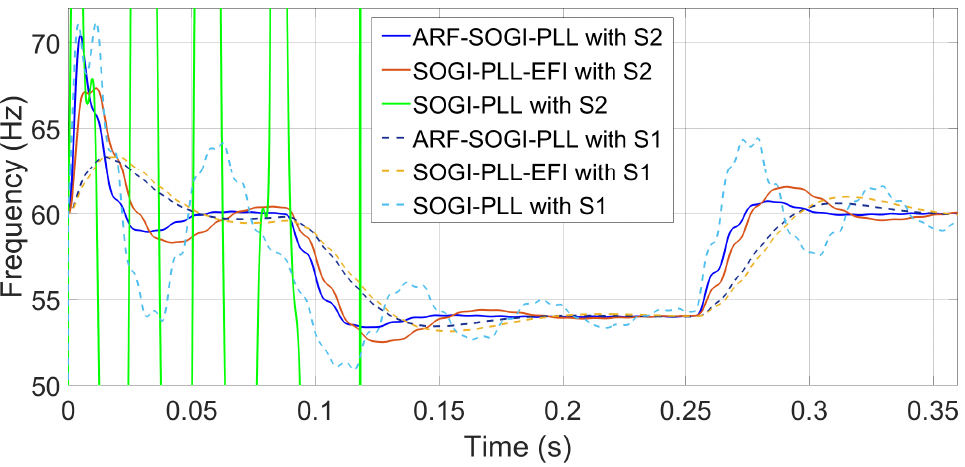
Figure 12. Frequency measured using a high bandwidth and a typical bandwidth in the PLLs in the face deviation of − 6 Hz in the frequency of the line